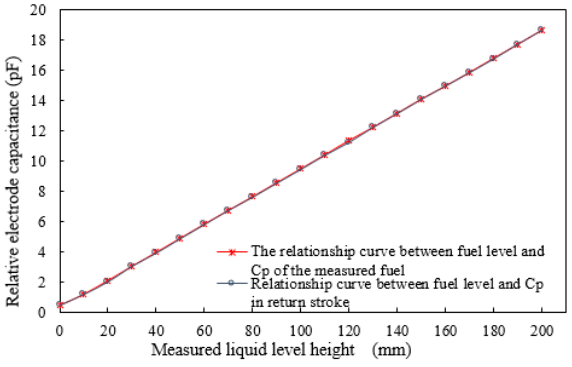
Figure 8. Characteristic curve of fuel level and average output capacitance C P.